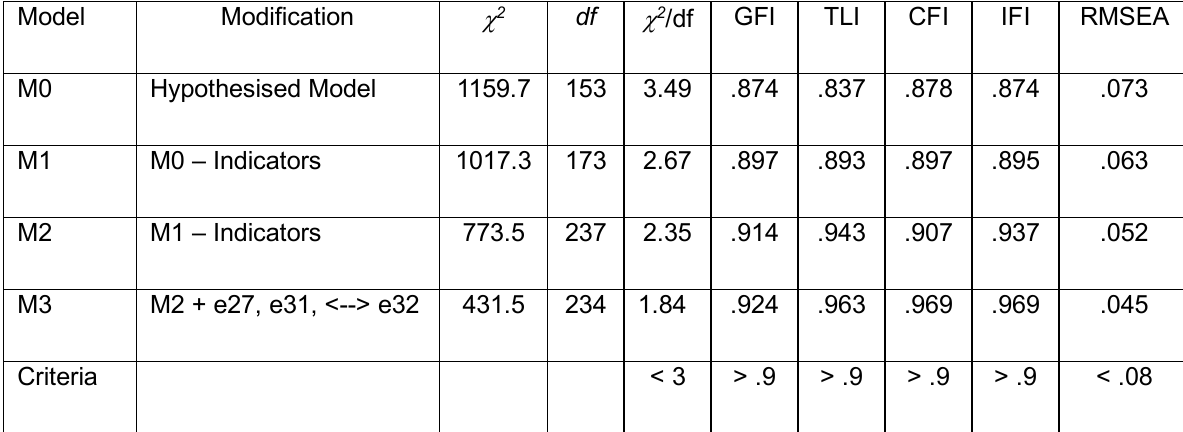
Table 6: Comparison of Model